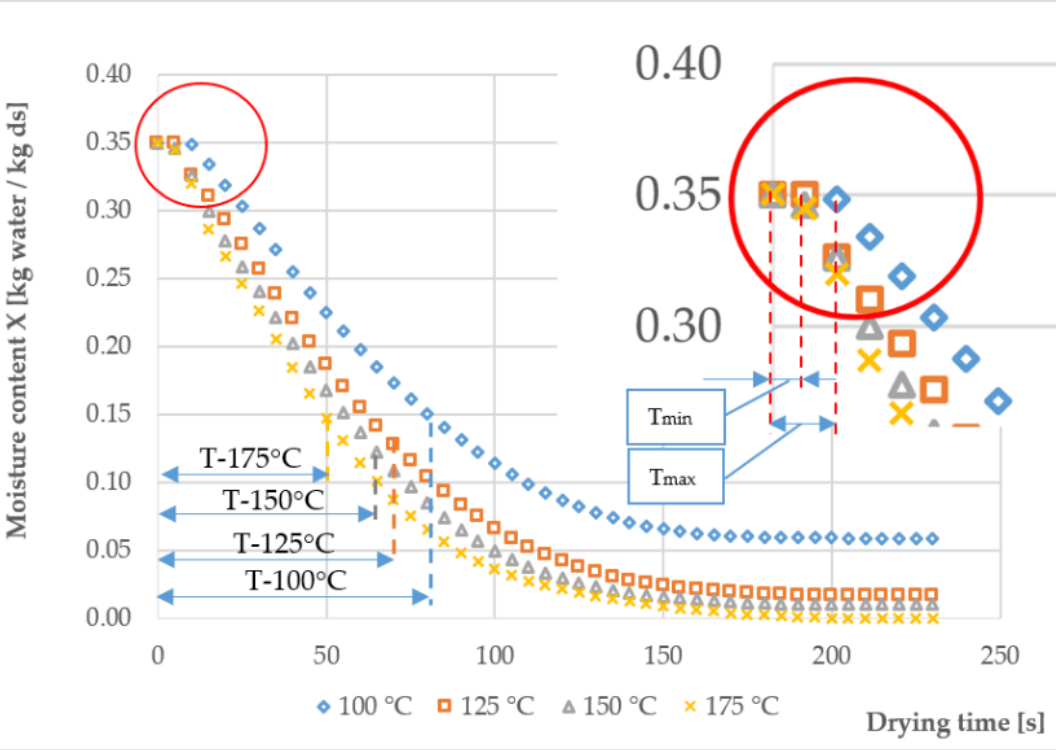
Figure 6. Drying curves of a wet pine sawdust tested at temperatures of 100, 125, 150 and 175 °C.